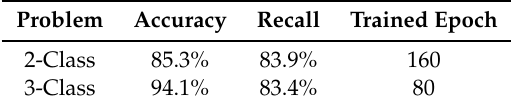
Table 3. The comparison of Accuracy/Recall on Ship and training time on 2-Class/3-Class